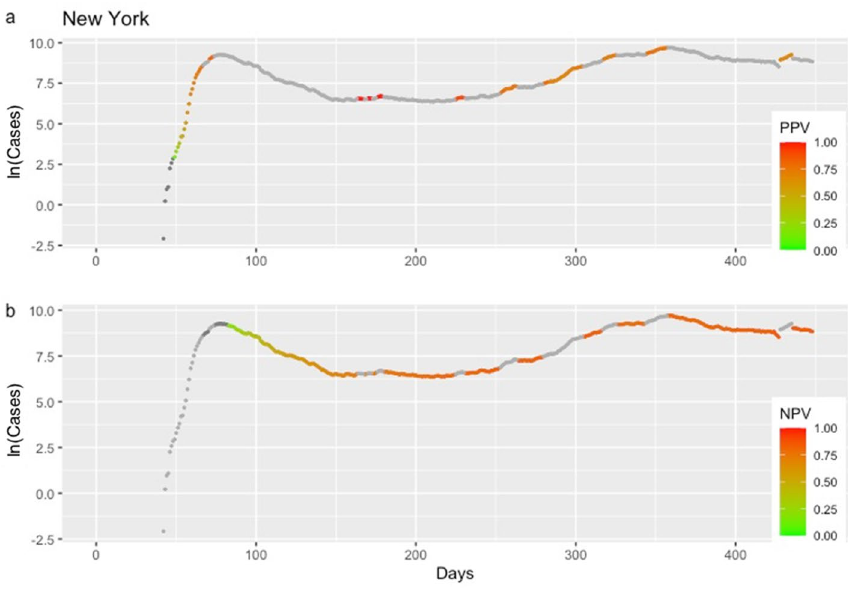
Figure 6. Positive and negative predictive values (PPV in 4a and NPV in 4b ), for the state of New York, depending on whether or not an early warning was issued. Higher color intensity corresponds to predictive values closer to the value of 1.